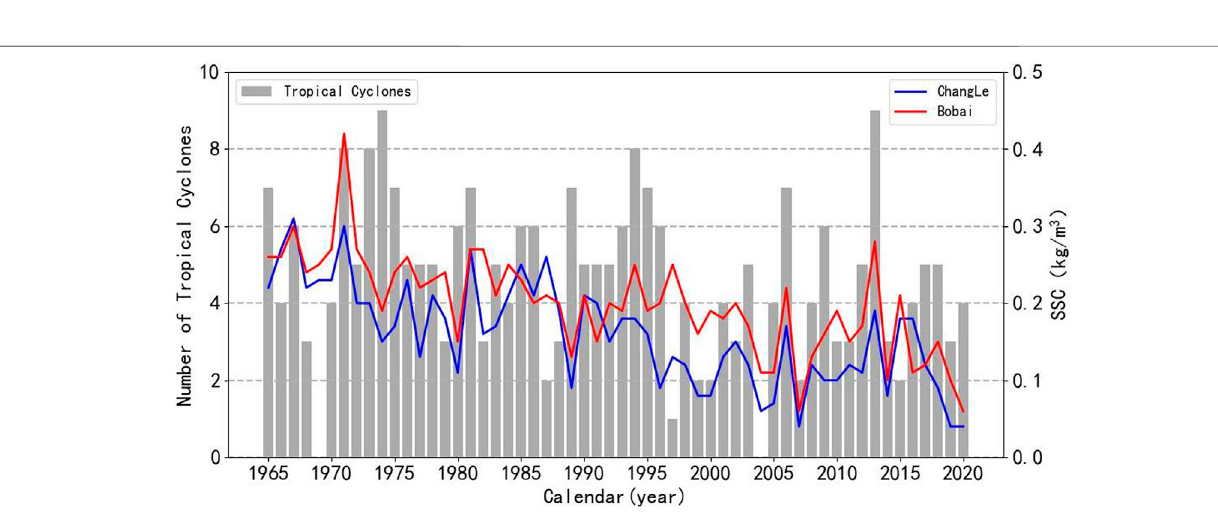
Frontiers in Earth Science |